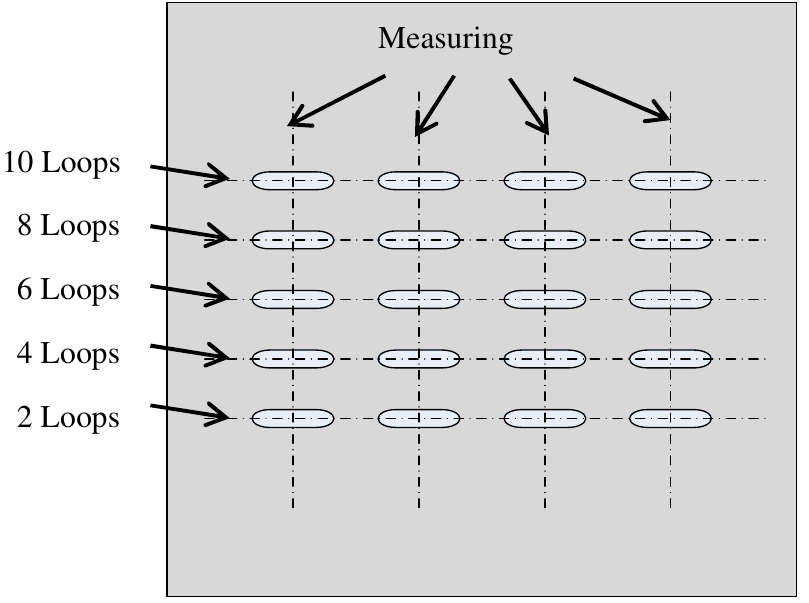
Figure 11. Evaluation of finishing efficiency. Figure 12 is the average value of the finishing depth of each group according to the finishing method described above. As the times of reciprocating finishing increase, the Table 1. Experimental conditions of evaluating finishing efficiency. finishing depth becomes deeper. Moreover, the finishing depth has a linear relationship with the number of reciprocations. After calculation, the average height reduction of the one loop process is about 1.88 µ